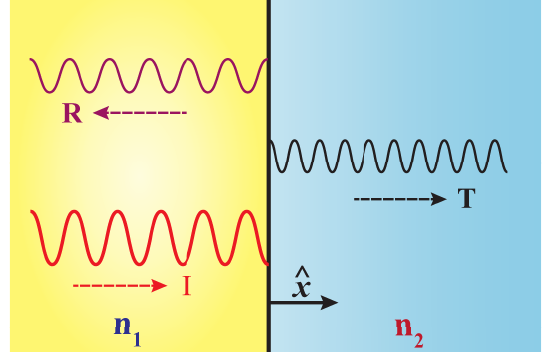
Figure 1. The scattering of an incident I wave to a reflected R and transmitted (refracted) T wave at an interface separating two di ff erent scalar dielectrics with refractive indices n 1 and n 2 . The interface is in the y - z plane; ˆ x is the outward pointing normal to the